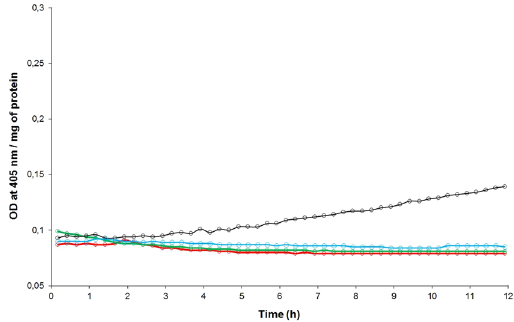
Figure 5. Caspase-3 activity on T. castaneum midguts following PA1b intoxication. The red flour beetles were intoxicated for 24 h with an artificial diet composed of 95% wheat flour and 5% yeast extract (control, blue curve). PA1b was incorporated in the diet (400 µ g per g, green curve); or pea flour containing PA1b was added to the diet (10%, red curve or 25% black curve). After intoxication, the midguts were dissected and the caspase-3 activities were measured using the artificial substrate DEVD-pNA.